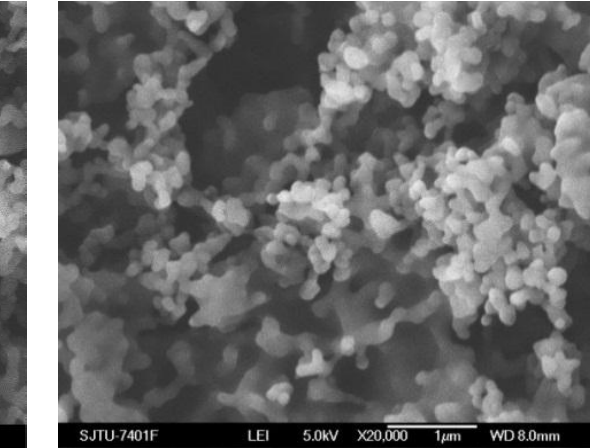
A 12 MPa, 35 °C, 1.0 mg/mL, 0.5 mL/min B 12 MPa, 35 °C, 1.0 mg/mL, 1.5 mL/min